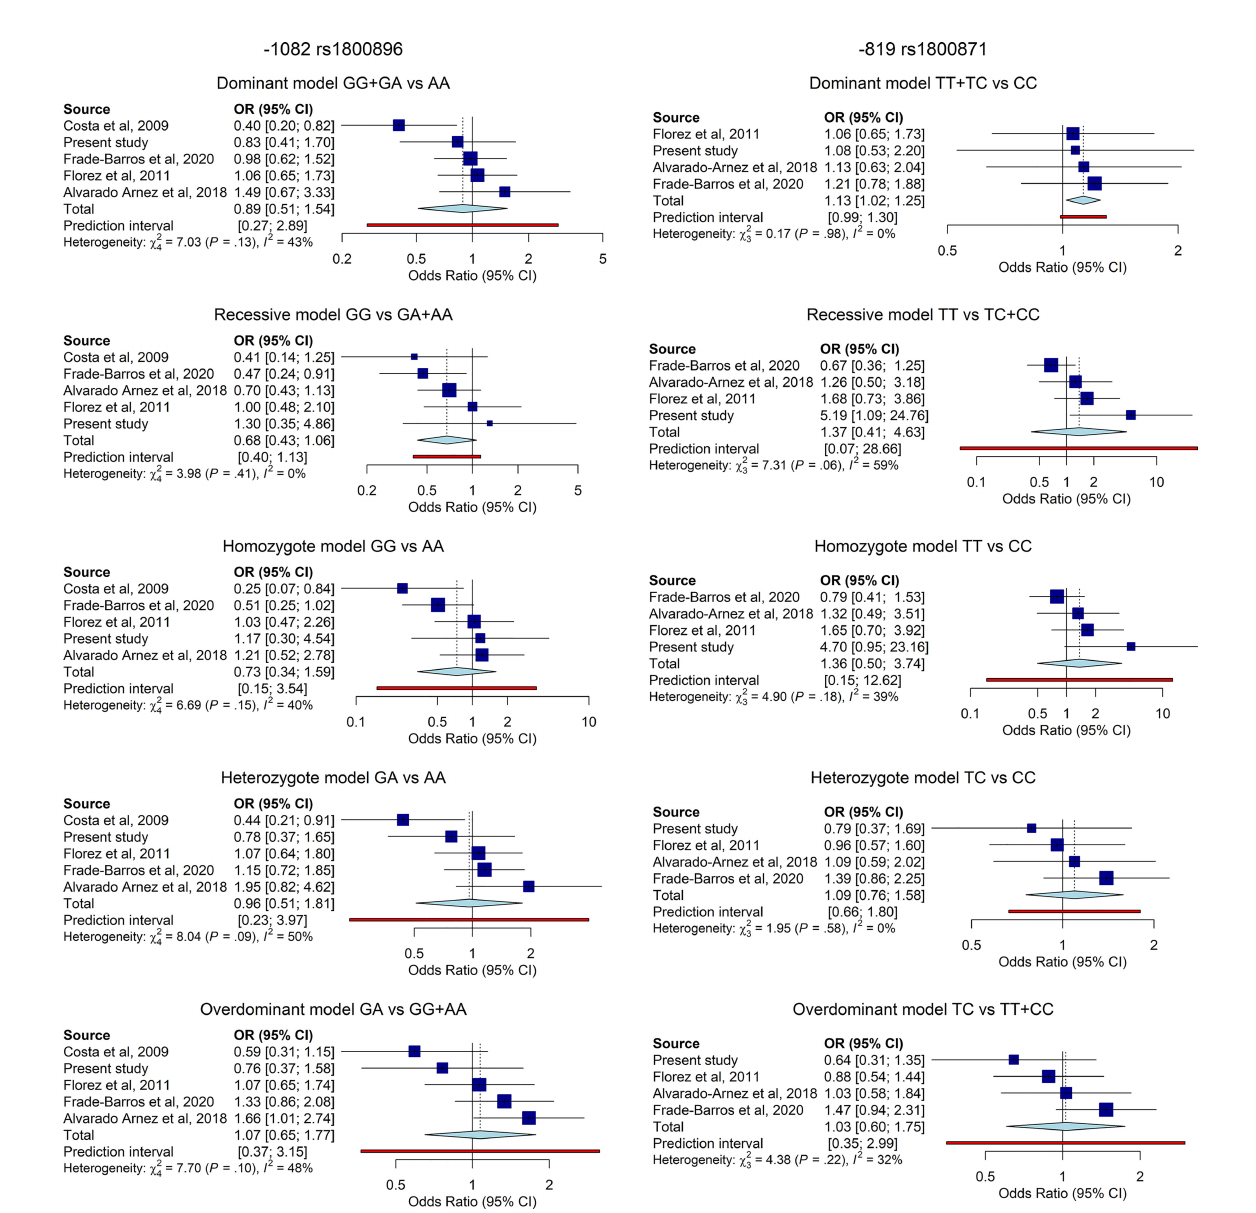
FIGURE 2 | Forest plot and pooled OR for the association of IL-10 -1082G>A (left), and (right) polymorphisms and risk of CCC among individuals with chronic T. cruzi infection under fi ve different genetic models. Horizontal lines represent the 95% con fi dence intervals around the point estimates for each study and the blue squares represent the OR whose size are proportional to the weight given to each study. The light blue diamonds represent the pooled effect and its 95% con fi dence intervals for all studies according to the random-effects model. Adjustment for age or gender was not performed due to the lack of information on such